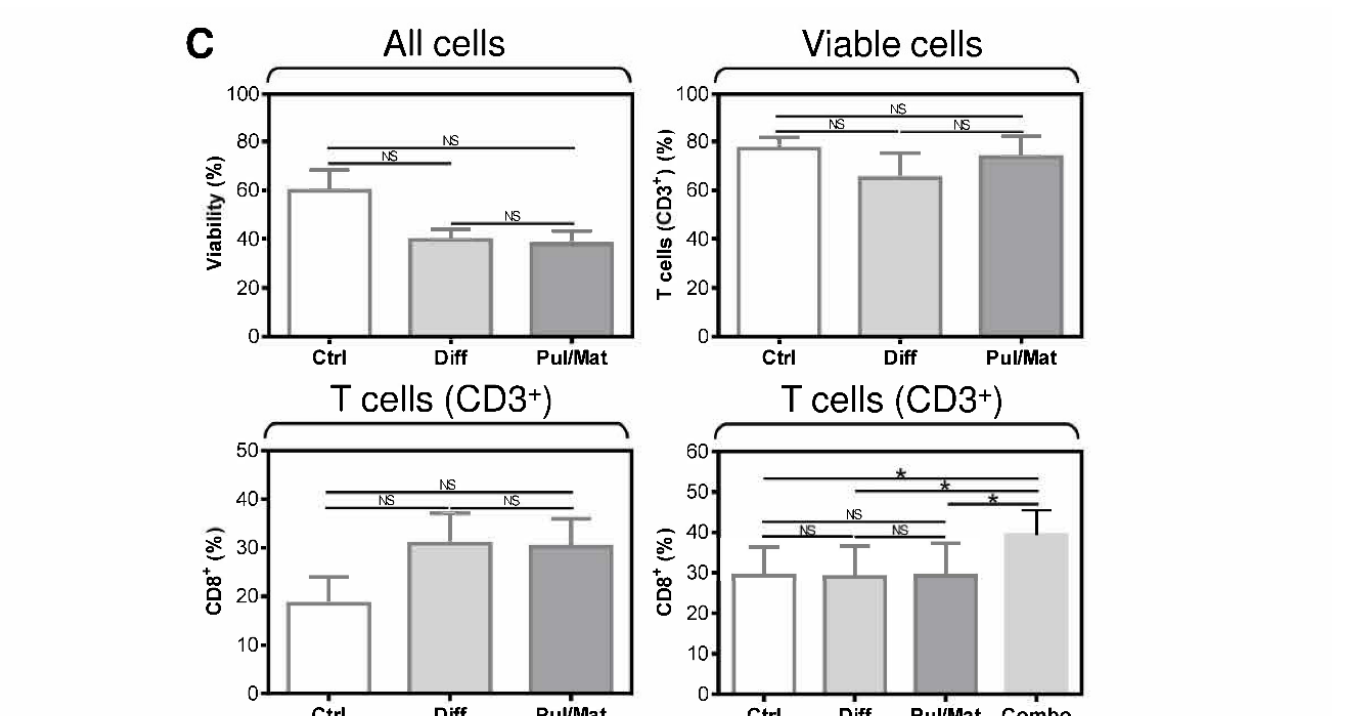
Figure 1. The impact of LL-37 on the DC functionality when implemented during DC differenti- ation or pulsation and maturation. ( A ) The LL-37 treatment strategy during ex vivo production of monocyte-derived DCs. The DCs were first differentiated from PBMCs to immature DCs in the presence of LL-37 (LL-37/iDC); then, following pulsation with antigen (Ag), they were matured using TLR7/8 agonist R-848 (LL-37/DC). The functionality of LL-37/DCs was tested in the 14-day-cultured lymphocytes generated by the stimulation of autologous lymphocytes with LL-37/DCs and subse- quent cell culturing in the presence of a low concentration IL-2 (20 IU/mL). ( B ) The gating strategy of flow cytometry data obtained from analyses of DC-stimulated and 14-day-cultured autologous lymphocytes. ( C ) The viability (top left panel), frequency of T cells (CD3 + ; top right panel), and their CD8 + population (bottom panels) in the 14-day-cultured autologous lymphocytes stimulated with DCs treated with LL-37 during their differentiation (Diff), or PC-3 pulsation and R-848-induced maturation (Pul/Mat), or differentiation, PC-3 pulsation, and R-848-induced maturation (Combo). In ( C ) , mean + SEM and significances of differences among the groups are indicated ( NS p > 0.05, * p < 0.05; ( C , top panels and bottom left panel) Ctrl: n = seven donors, Diff and Pul/Mat: n = six donors; one-way ANOVA with Tukey’s post-test; ( C , bottom right panel) n = six donors; repeated measures (paired) one-way ANOVA with Tukey’s